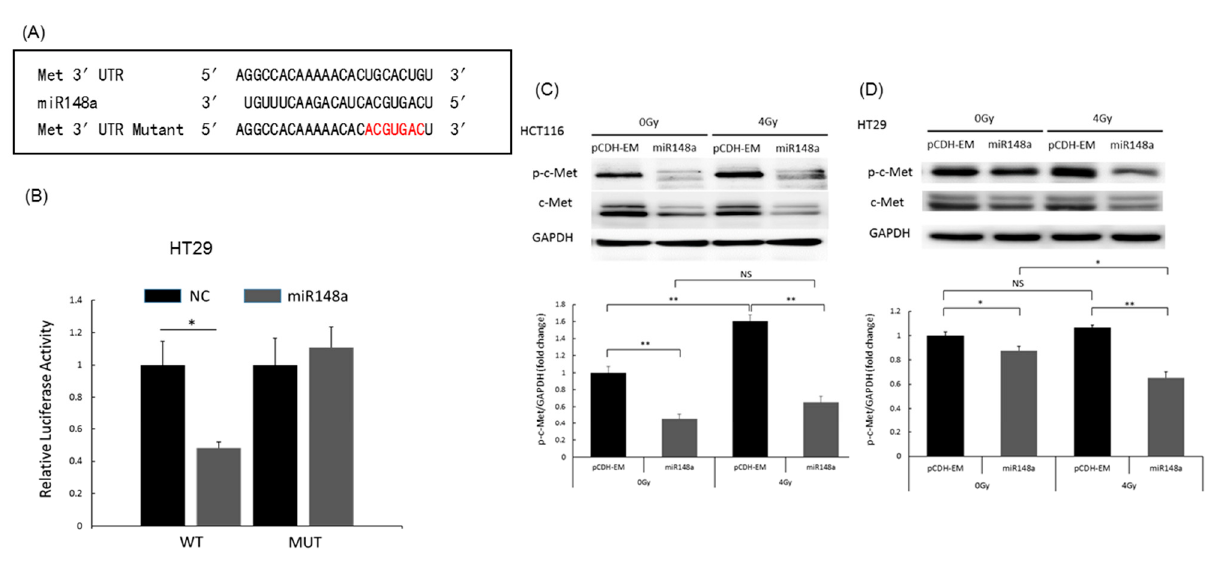
Figure 6. c-Met is a target gene of miRNA-148a and is mediated in CRC cells. ( A ) The complementary sequences of miRNA148a and c-Met , as well as the mutant sequences of the c-Met binding site. ( B ) Wild-type c-Met binds to miRNA-148a, whereas the MUT does not. ( C ) In HCT116 cells, c-Met expression changed with miRNA-148a expression and irradiation. Figure 6. c ‐ Met is a target gene of miRNA ‐ 148a and is mediated in CRC cells. ( A ) The complementary sequences of ( D ) In HT29 cells, c-Met expression changed with miRNA-148a expression and irradiation. (N = 3; * p < 0.05; ** p < 0.01). miRNA148a and c ‐ Met , as well as the mutant sequences of the c ‐ Met binding site. ( B ) Wild ‐ type c ‐ Met binds to miRNA ‐ NC: negative control; MUT: 148a, whereas the MUT does not. ( C ) In HCT116 cells, c ‐ Met expression changed with miRNA ‐ 148a expression and irra ‐ diation. ( D ) In HT29 cells, c ‐ Met expression changed with miRNA ‐ 148a expression and irradiation. (N = 3; * p < 0.05; ** p < 0.01). NC: negative control; MUT: mutant.